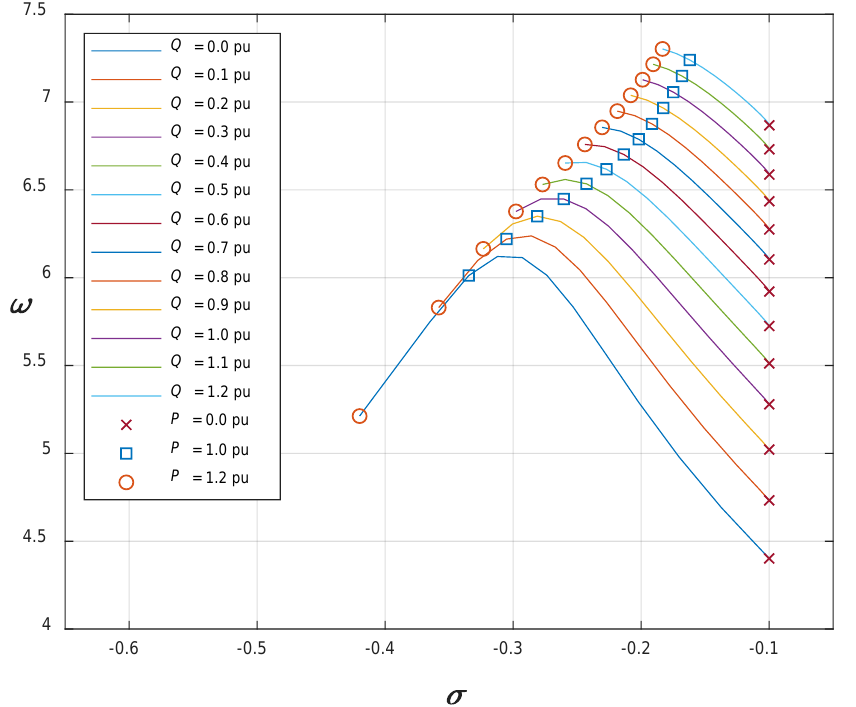
Figure 5. Eigenvalue loci of local mode of 25-MVA turbo-type synchronous generator without AVR.